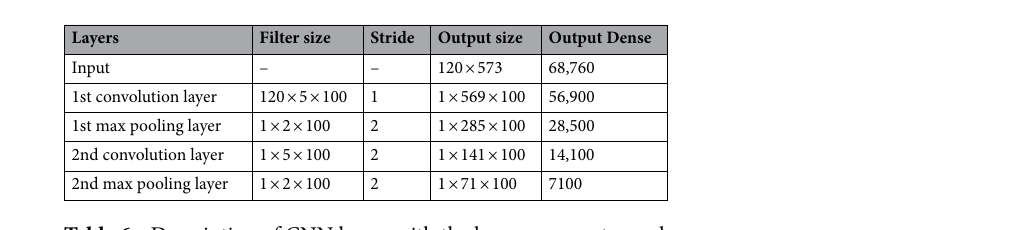
Table 6. Description of CNN layers with the hyper-parameters